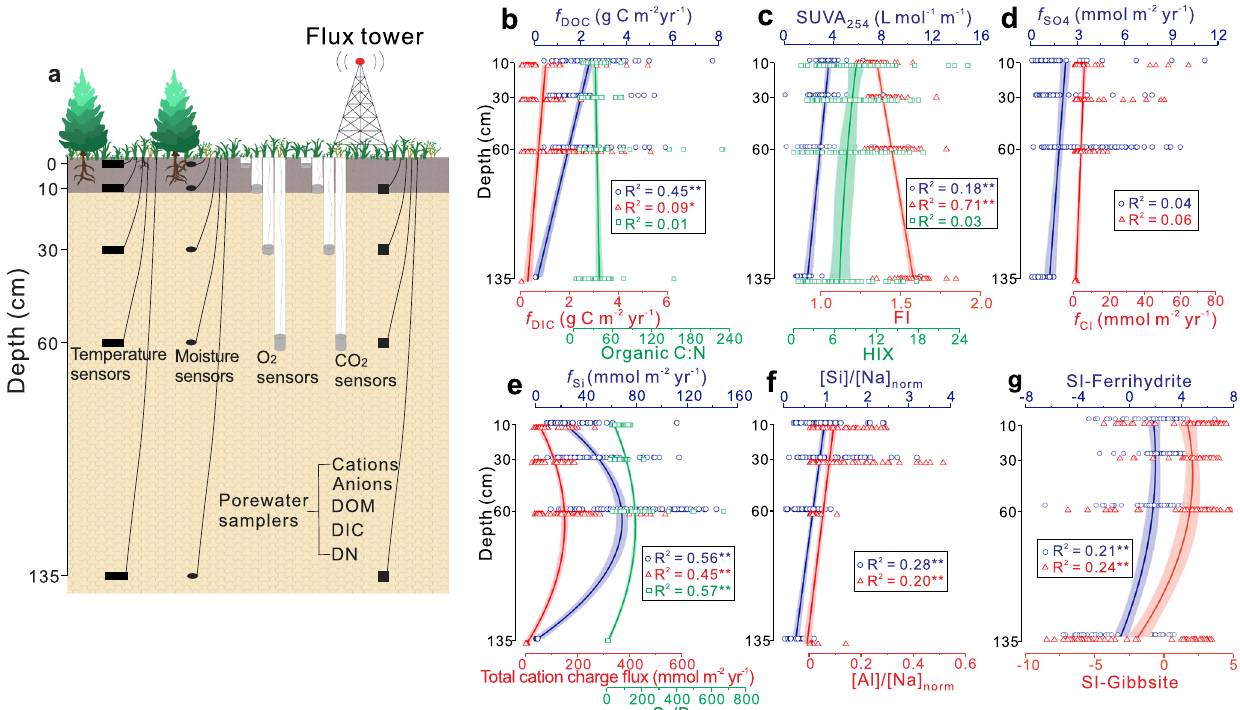
fl ux ( f fl ux, and Sr/Ba ratio, ( f ) proxies for weathering con- Fig. 2 | Field monitoring schema and biogeochemical proxy variation as a Si ), total cation charge function of soil depth. a Field monitoring of soil temperature, moisture and gas gruencyincluding[Si]/[Na] norm and[Al]/[Na] norm ,and ( g )saturationindices(SI)for partialpressure, aswell assoilporewatersampling. Soiltemperatureand moisture secondary minerals ferrihydrite and gibbsite. Proxies for mineral weathering weremonitored atdepthsof 2,10,30,60, and 135cm, and soilO 2 and CO 2 at2,10, intensity show overall similar depth trends, con fi rming the predominance of sili- 30, and 60cm.Porewatersweresampled at10,30,60, and 135cm.Dataand depth cate weathering in the soil pro fi le and validating the use of these proxies for ana- trends of ( b ) dissolved organic carbon (DOC) fl ux ( f DOC ), dissolved inorganic car- lysisofmineralweatheringintensity.Weatheringhasthehighestintensityat60cm, bon (DIC) fl ux ( f DIC ) and organic C:N ratio of dissolved organic matter (DOM), ( c ) consistent with the trends of SI of secondary minerals. The data are from all three DOM composition-related parameters including speci fi c ultraviolet absorbance at instrumented pedons. Shaded areas represent 95% con fi dence intervals. **denotes 254nm (SUVA 254 ), humi fi cation index (HIX) and fl uorescence index (FI), ( d ) SO 4 2 − signi fi cant data fi t at p <0.01 and *signi fi cant data fi t at p − fl ux( f fl ux( f SO4 )and Cl Cl ),( e )proxiesformineralweatheringintensityincludingSi